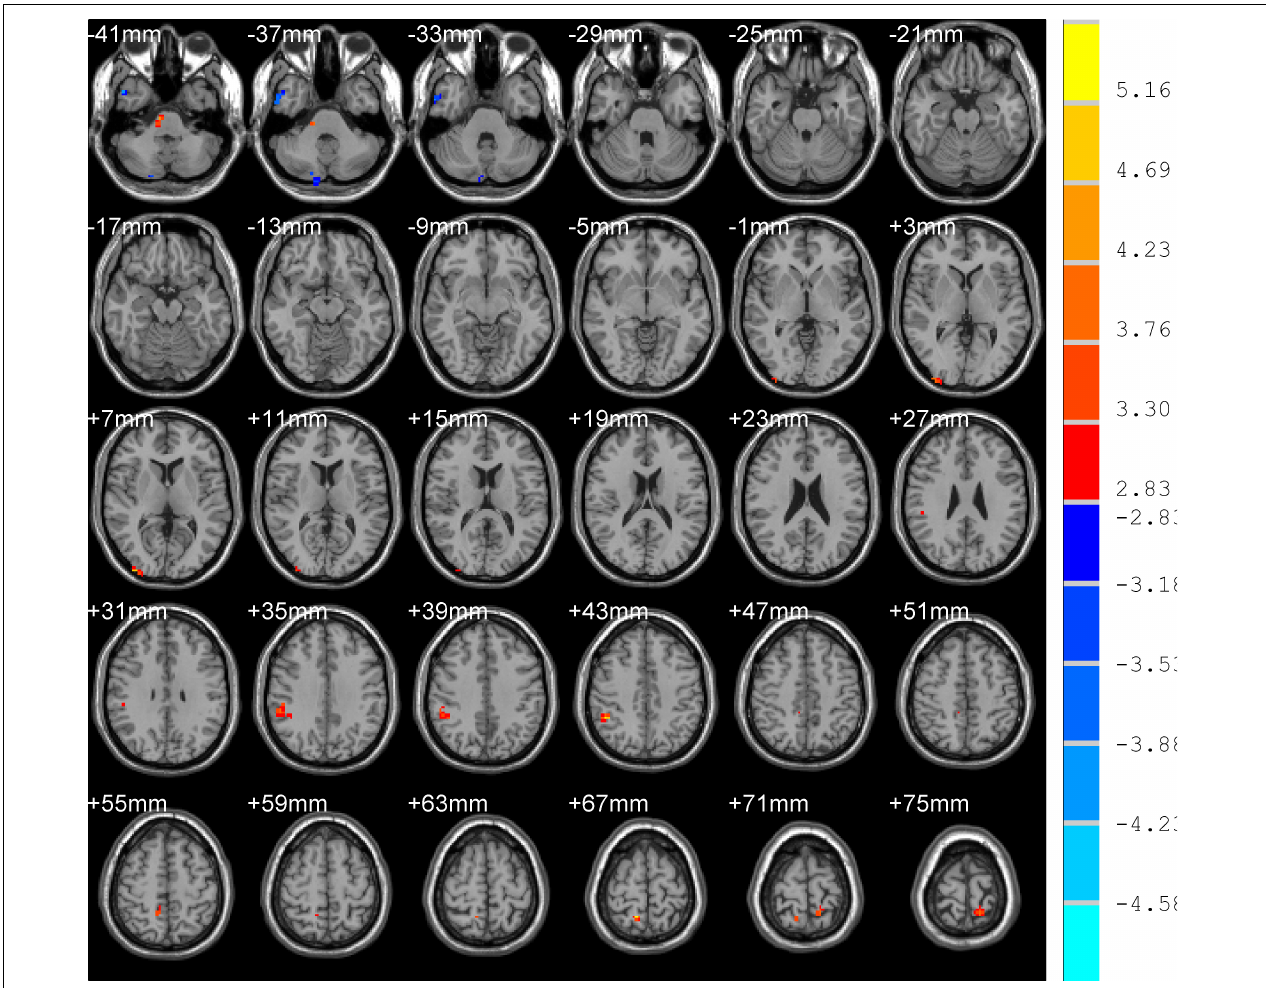
FIGURE 1 | Compared with HC, TOF children showed increased ReHo values in the right brainstem, right middle occipital gyrus, right inferior parietal gyrus, right precuneus, and left precuneus, and decreased ReHo values in the right posterior lobe of the cerebellum and right inferior temporal gyrus. AlphaSim correction with P < 0.01; cluster size >